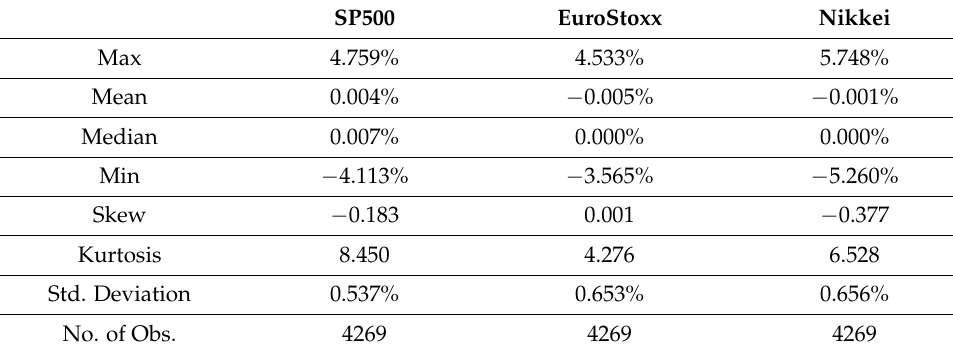
Table 2. Advanced Economy Stock Market Summary Statistics.